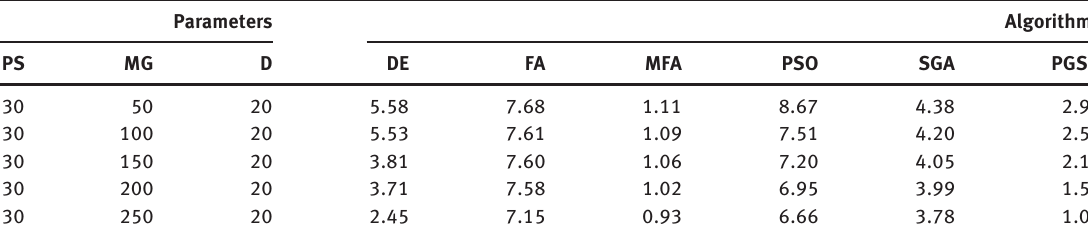
Table 11. Standard Deviation on Different Evolutionary Generations.